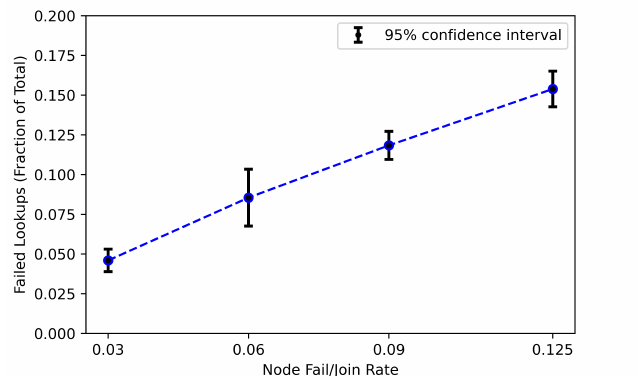
Figure 12. Failed lookups as a function of node fail/join